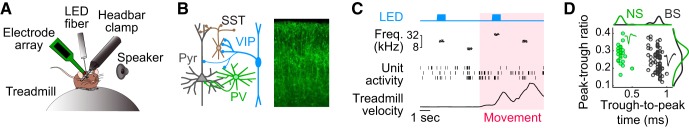
Extracellular recording and optogenetic manipulation of ACtx neurons in freely moving mice. A, Mice are head fixed atop a spherical treadmill to permit movement but constrain head position for extracellular physiology. A window in the headbar provides access to ACtx of the right hemisphere for extracellular recording with linear multielectrode arrays and optogenetic manipulation via LED fiber optic cables. Sounds are presented to the contralateral ear through an electrostatic speaker. B, Optogenetic activation of VIP+ inhibitory interneurons in ACtx. Left, Schematic of prominent connections among cortical inhibitory interneurons and pyramidal neurons. Sst+ and Pvalb+ interneurons predominantly connect to pyramidal dendrites and somata, respectively. VIP+ interneurons most prominently connect to Sst+ interneurons. Thus, VIP+ interneuron activation by blue light (right) thus tends to disinhibit pyramidal neurons by reducing Sst+ interneuron-mediated inhibition. Right, Control of VIP+ interneurons via blue light was accomplished by crossing VIP-Cre mice with Ai32 mice to express channelrhodopsin-2 in Cre-expressing VIP interneurons. Histology figure from ACtx in a representative Ai32/VIP-Cre mouse expressing eYFP-tagged ChR2 (green) in VIP+ interneurons. Scale bar, 100 μm. C, Stimuli comprised 500 ms tone clouds spanning 4–64 kHz presented in pseudorandom order. Optogenetic stimulation was delivered for half of all trials in pseudorandom order. Simultaneous recording from 2–15 neurons was permitted by 32-channel linear multielectrode arrays. Treadmill velocity was stored for off-line analysis, yielding both still and movement periods. D, Each unit was characterized by its peak/trough ratio (peak height divided by trough depth) and trough-to-peak time. A sharply bimodal distribution of trough-to-peak times permitted straightforward identification of NS (putative inhibitory) and BS (putative excitatory) neurons. Inset plots show example NS and BS waveforms (mean ± SD).